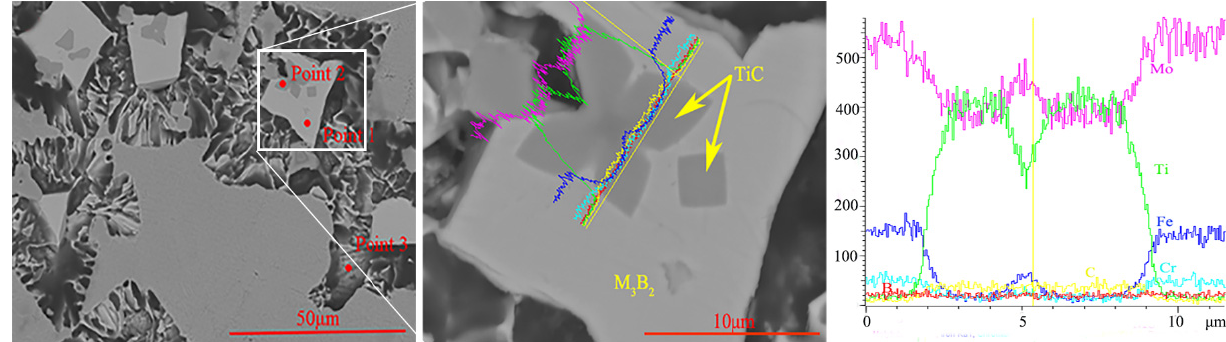
Figure 5. SEM analysis of claddings with 15% TiC contents and EDS line scan analysis. Table 2. Element content in different structures in the cladding with 15% TiC.